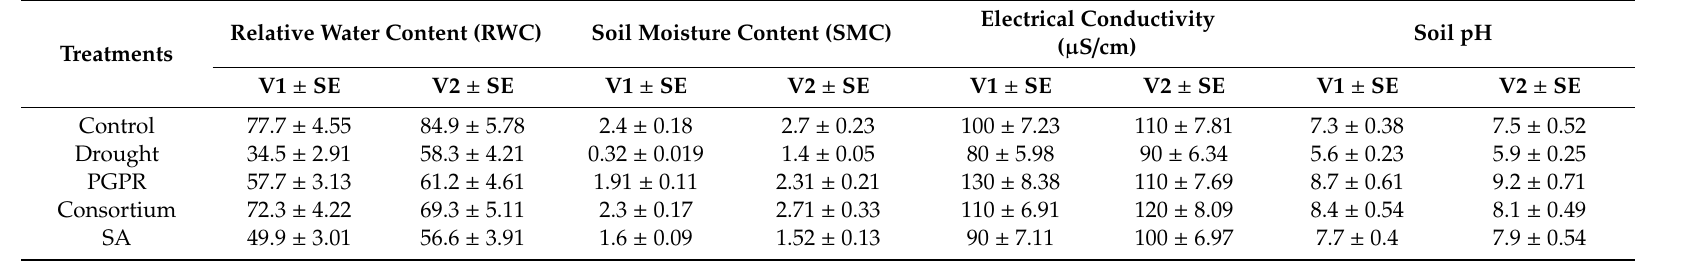
Table 7. Relative water content (%), soil moisture content (%), electrical conductivity and soil pH.